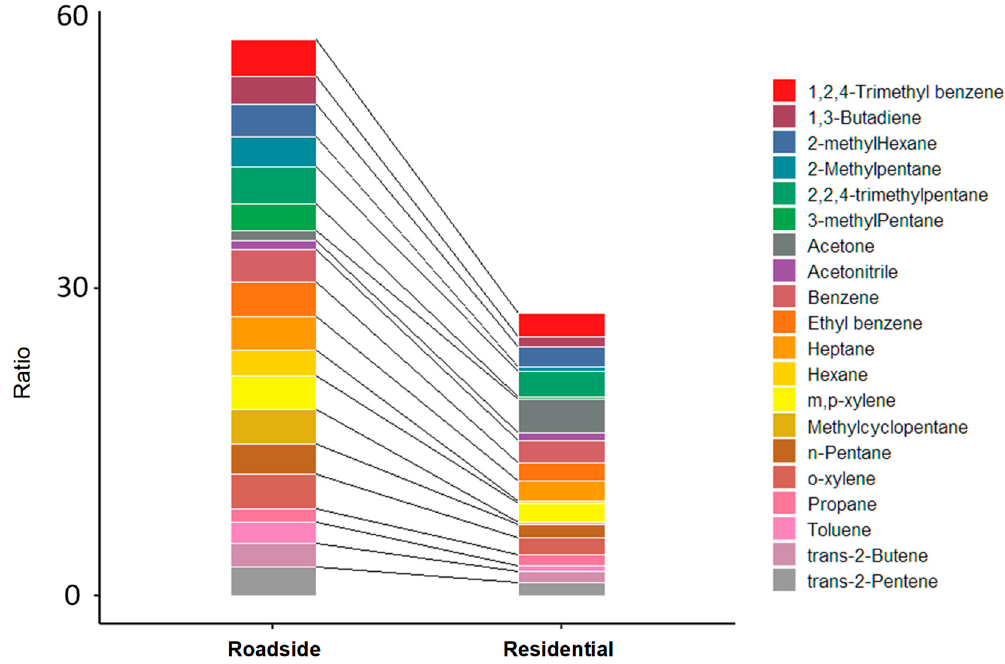
Figure 4. VOC species concentration ratios of rush hour periods and non-rush hour periods at roadside and residential sites.